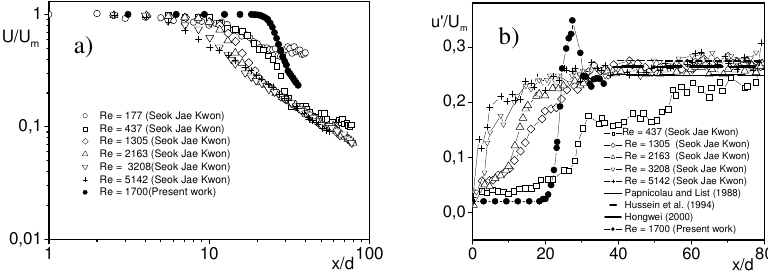
Fig. 2. The distribution of mean values (a) and intensity of turbulent fluctuations (b) of the longitudinal velocity along the axial line of the jet. Comparison of present work experimental data with the data of other